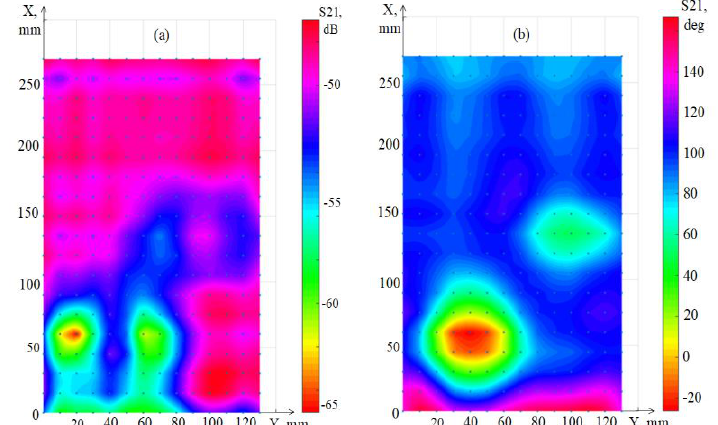
Fig. 7. Measurement results of the amplitude (a) and phase (b) of the transmission coefficient with a 900 MHz signal.